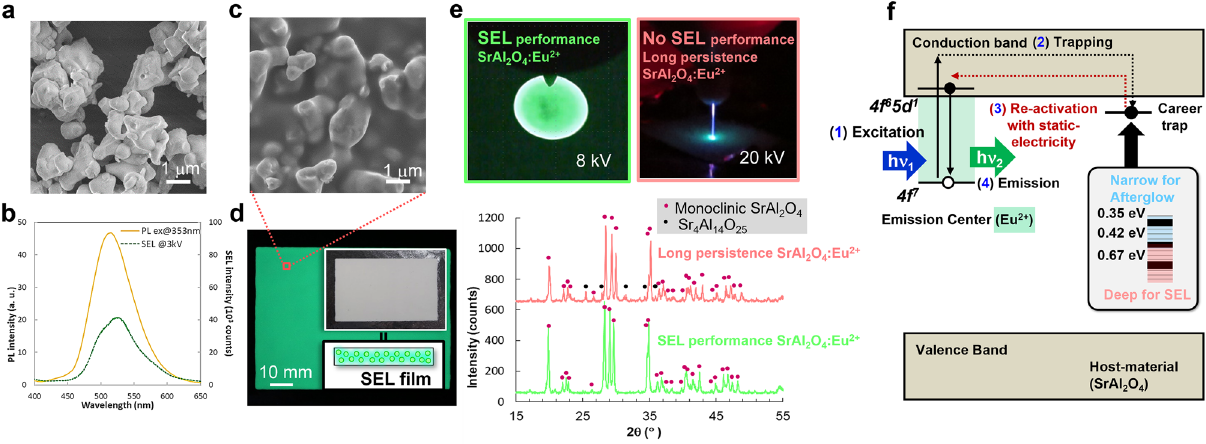
Figure 4. A SrAl 2 O 4 : Eu 2+ static electricity induced luminescence material (SEL). ( a ) Scanning electron microscopy (SEM) of SEL material SrAl 2 O 4 :Eu 2+ . ( b ) Emission spectrum of SrAl 2 O 4 :Eu 2+ . ( c , d ) SEM and Film of SEL prepared by mixing SrAl 2 O 4 :Eu 2+ and an acrylic resin. ( e ) X-ray diffraction of SEL performance and no SEL performance